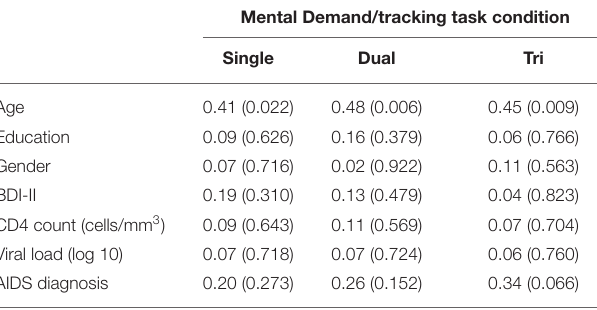
TABLE 3 | Correlations between demographic, psychological, and medical variables with Mental Demand ratings on the NASA-TLX in adults with